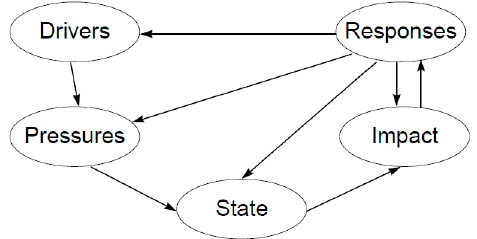
Figure 1. The DPSIR (Drivers, Pressures, State, Impacts, Responses) framework